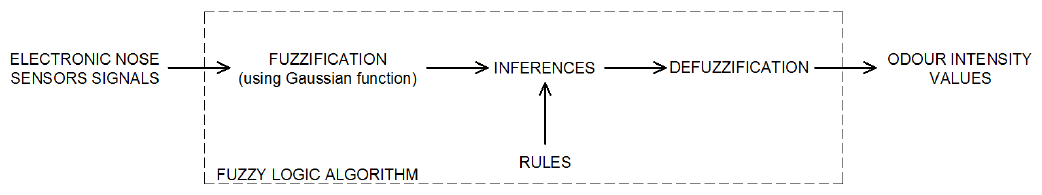
Figure 3. Fuzzy logic algorithm for the odor intensity estimation using electronic nose sensors signals.